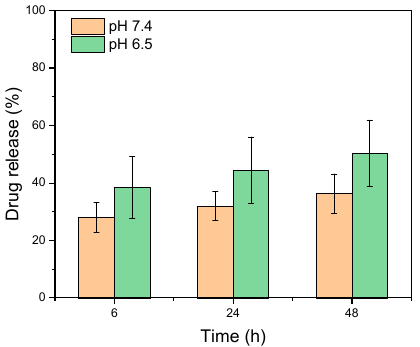
Figure 3. Drug leakage and release of IMQ-containing liposomes in different pH environments. IMQ: imiquimod.